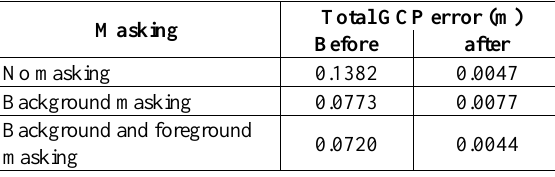
Table 3. Influence of masking for results with iPhone 4S before and after